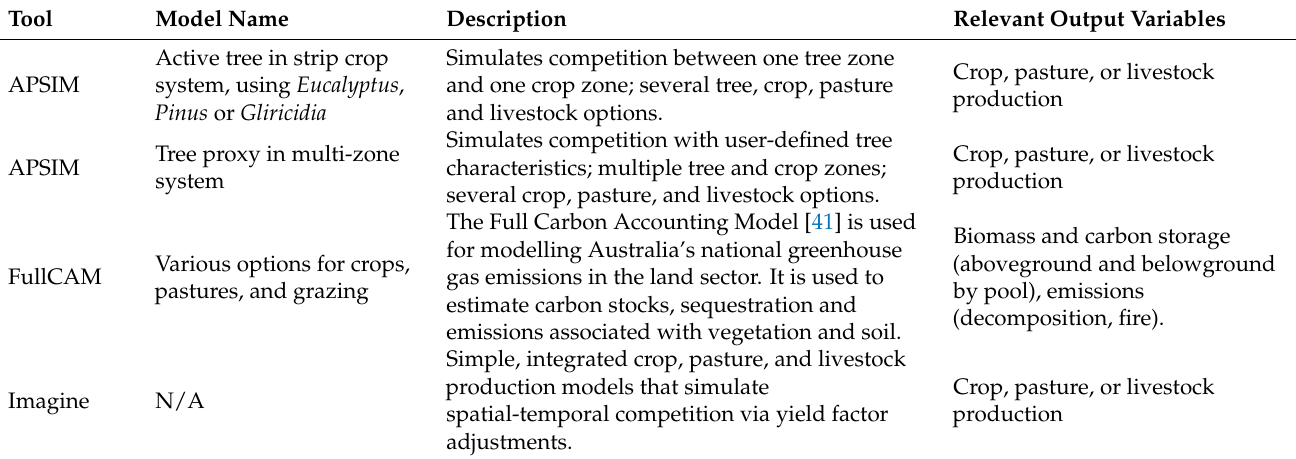
Table 3. Summary of the shortlisted tools and associated models that quantify crop, pasture, or livestock